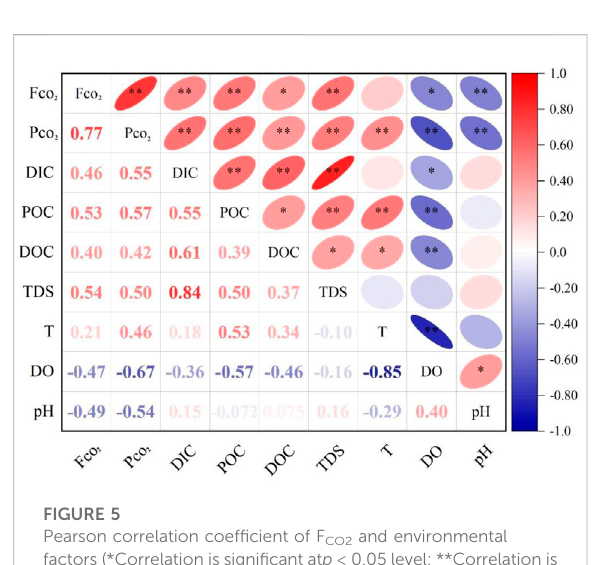
FIGURE 5 Pearson correlation coef fi cient of F CO2 and environmental factors (*Correlation is signi fi cant at p < 0.05 level; **Correlation is signi fi cant at p < 0.01